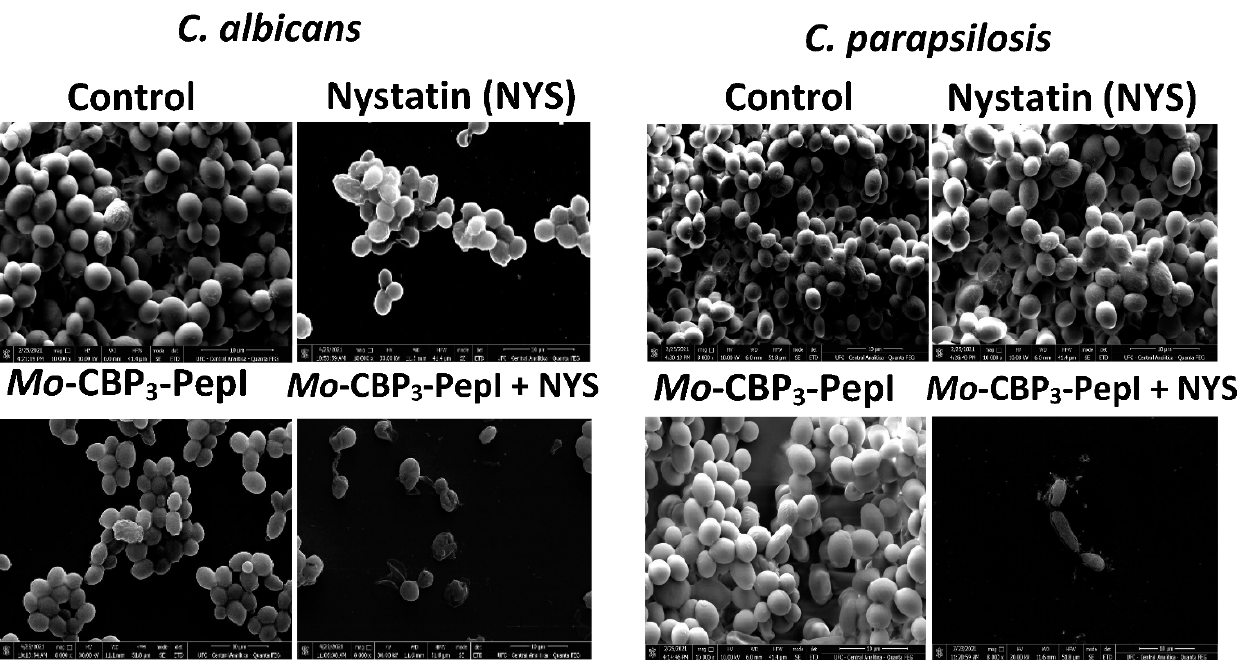
Figure 4. SEM images showing alterations of mature biofilm of C. albicans and C. parapsilosis after treatment with Mo -CBP 3 -PepI, NYS and Mo -CBP 3 -PepI + NYS. Control: DMSO-NaCl solution.